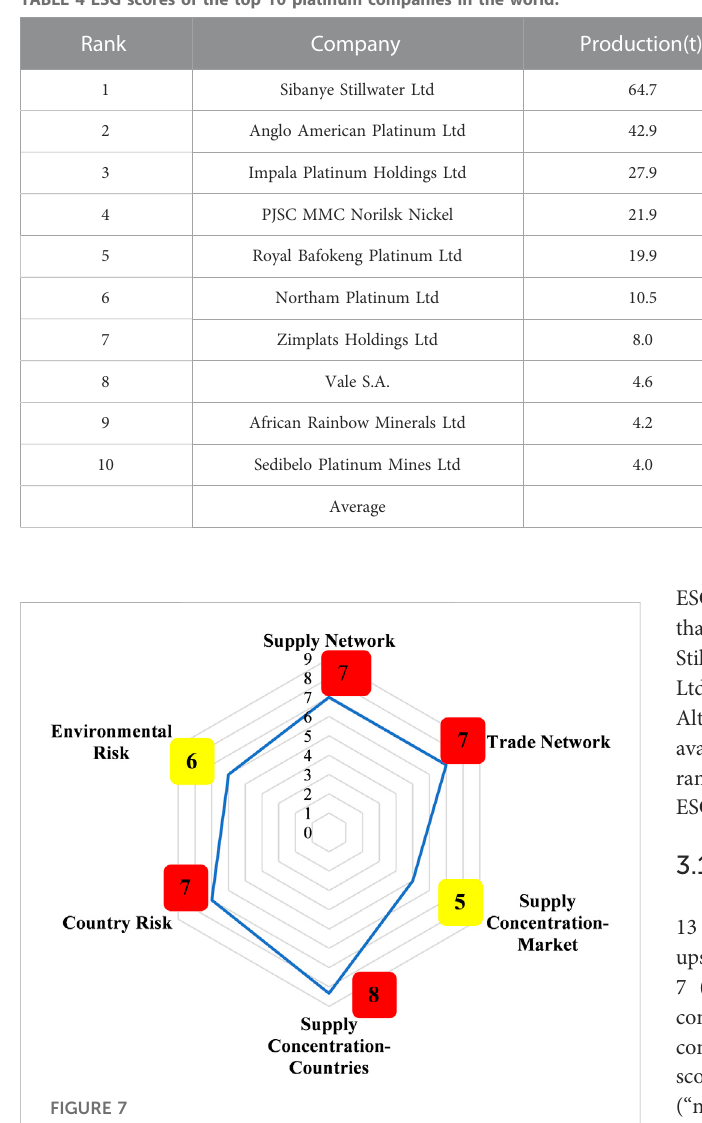
Radar chart of overall assessment of global platinum supply